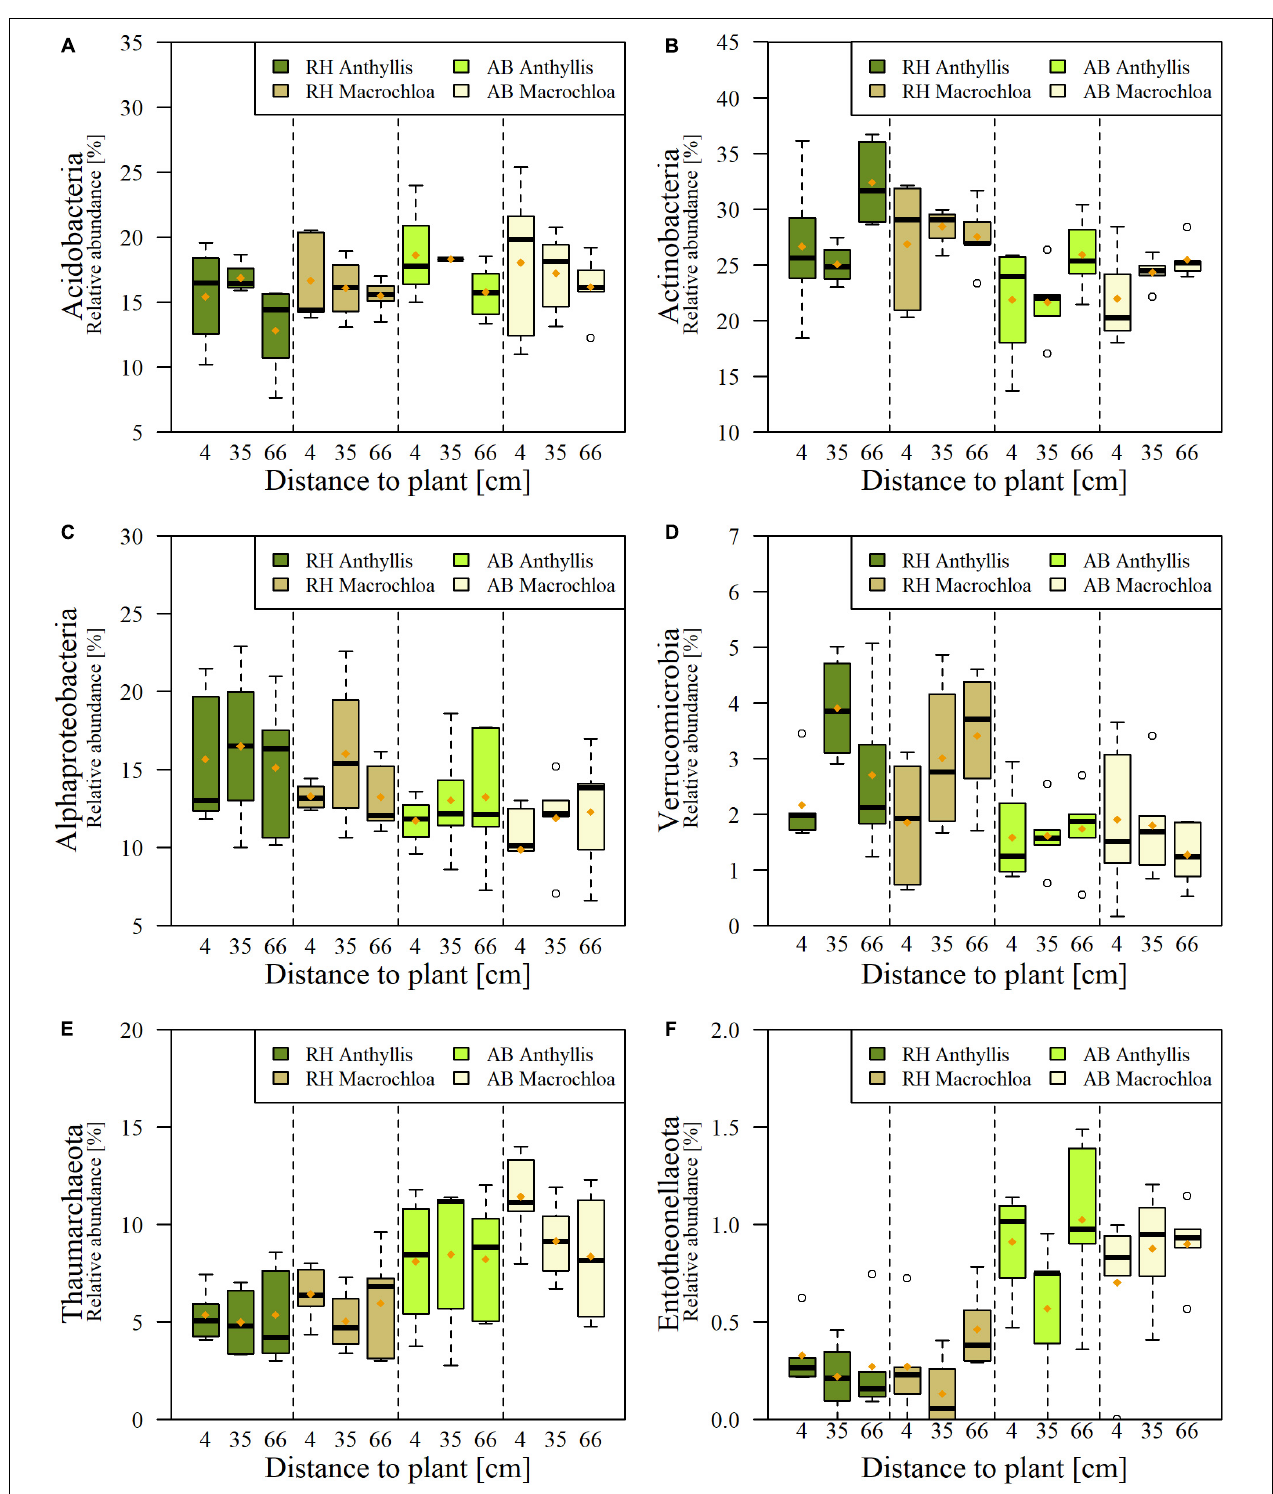
FIGURE 4 | Relative abundance (%) of phyla showing significant differences between Rambla Honda (RH) and Alboloduy (AB) site for Anthyllis cytisoides or Macrochloa tenacissima : Acidobacteria (A) , Actinobacteria (B) , Alphaproteobacteria (C) , Verrucomicrobia (D) , Thaumarchaeota (E) , and Entotheonellaeota (F) .